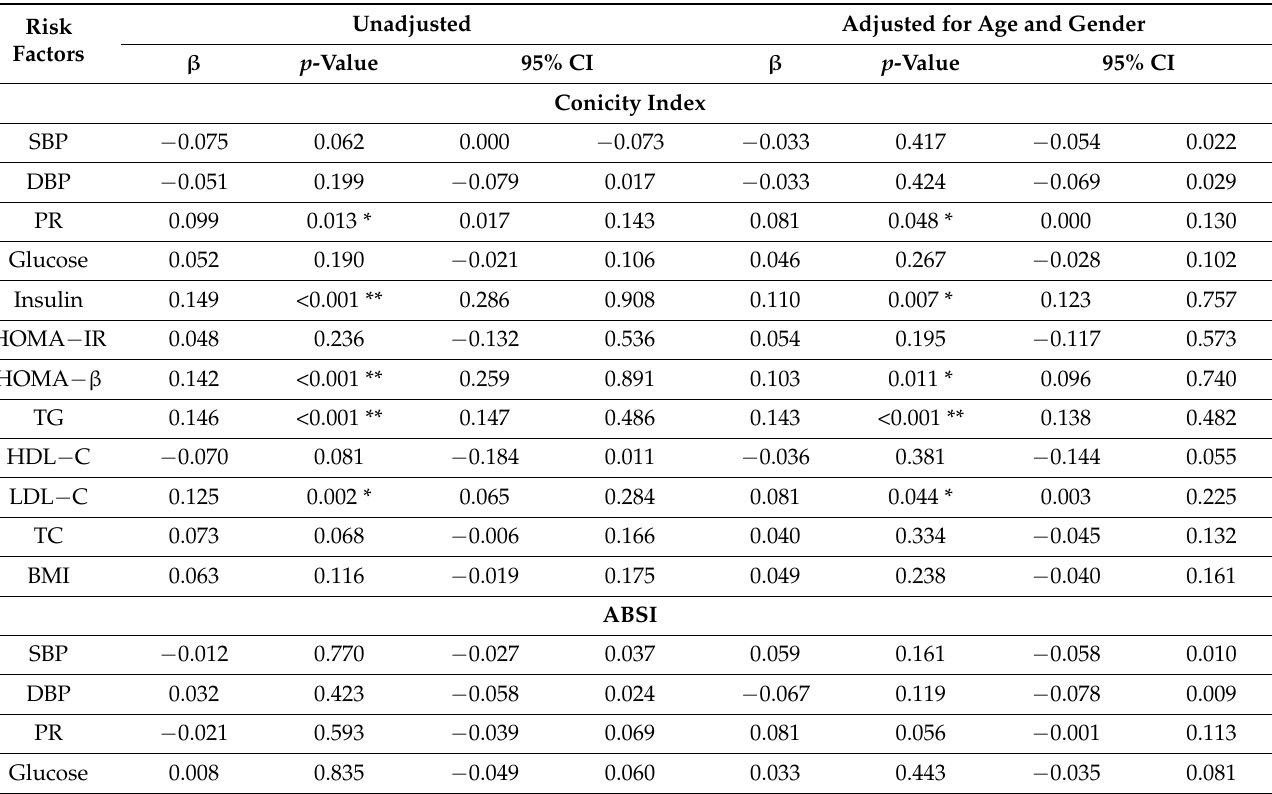
Table 3. Linear regression of anthropometric indices and cardiovascular risk factors of Ellisras young adults aged 21– 30